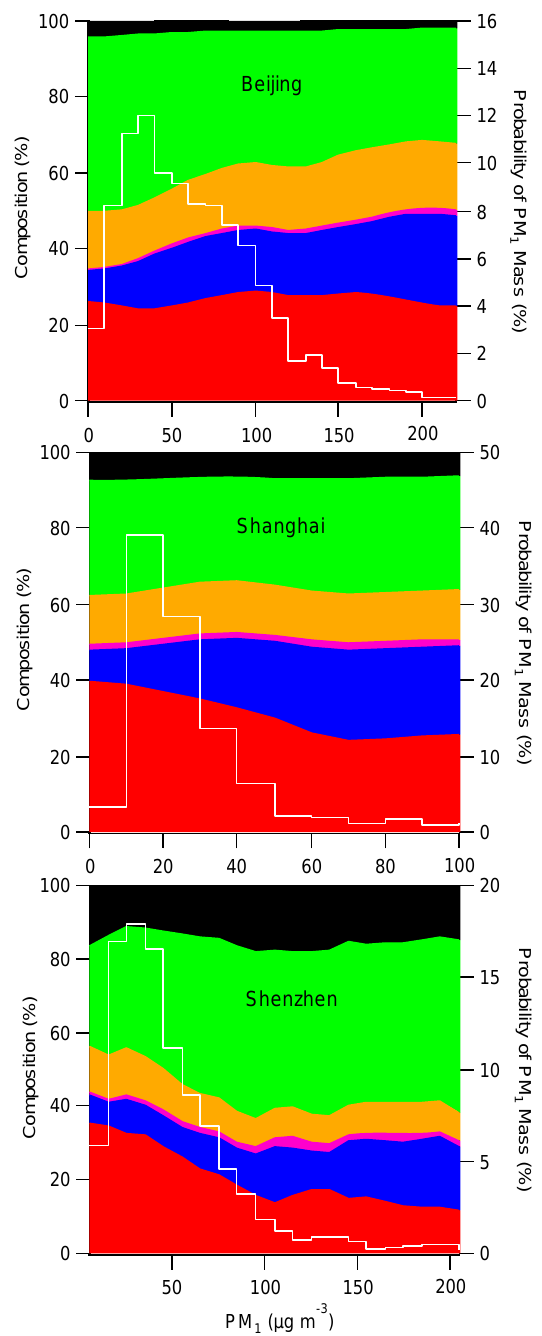
Fig. 2. The variation of percent composition with PM 1 mass con- centration in Shanghai, as well as in Beijing and